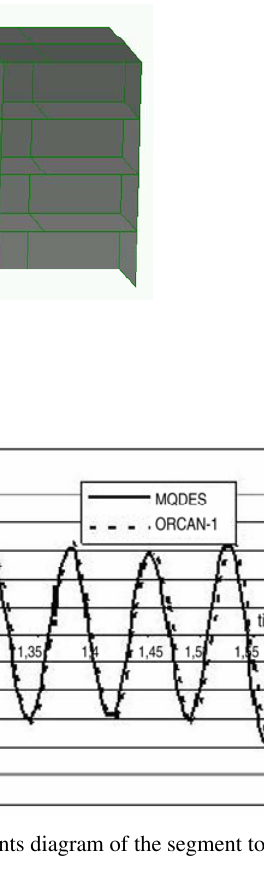
Fig 10 . Displacements diagram of the top of the segment in w direction